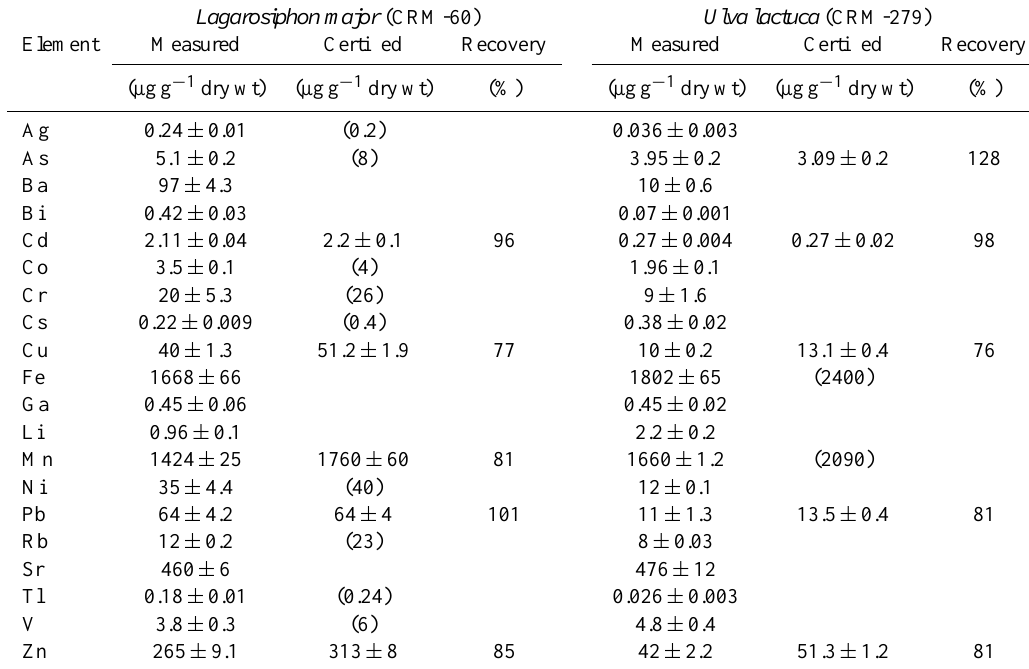
Table 1. Analysis of the reference materials of the Community Bureau of Reference Ulva lactuca CRM 279 and Lagarosiphon major CRM 060: certified values, measured values and recovery (mean ± SD). Certified values are given when they are available from the Community Bureau of Reference. Values in parentheses are indicative values of the reference